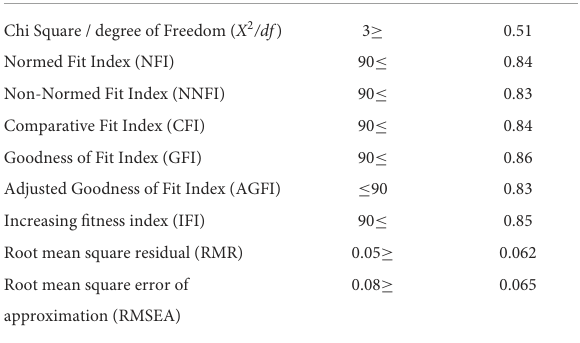
Initial model Fitted